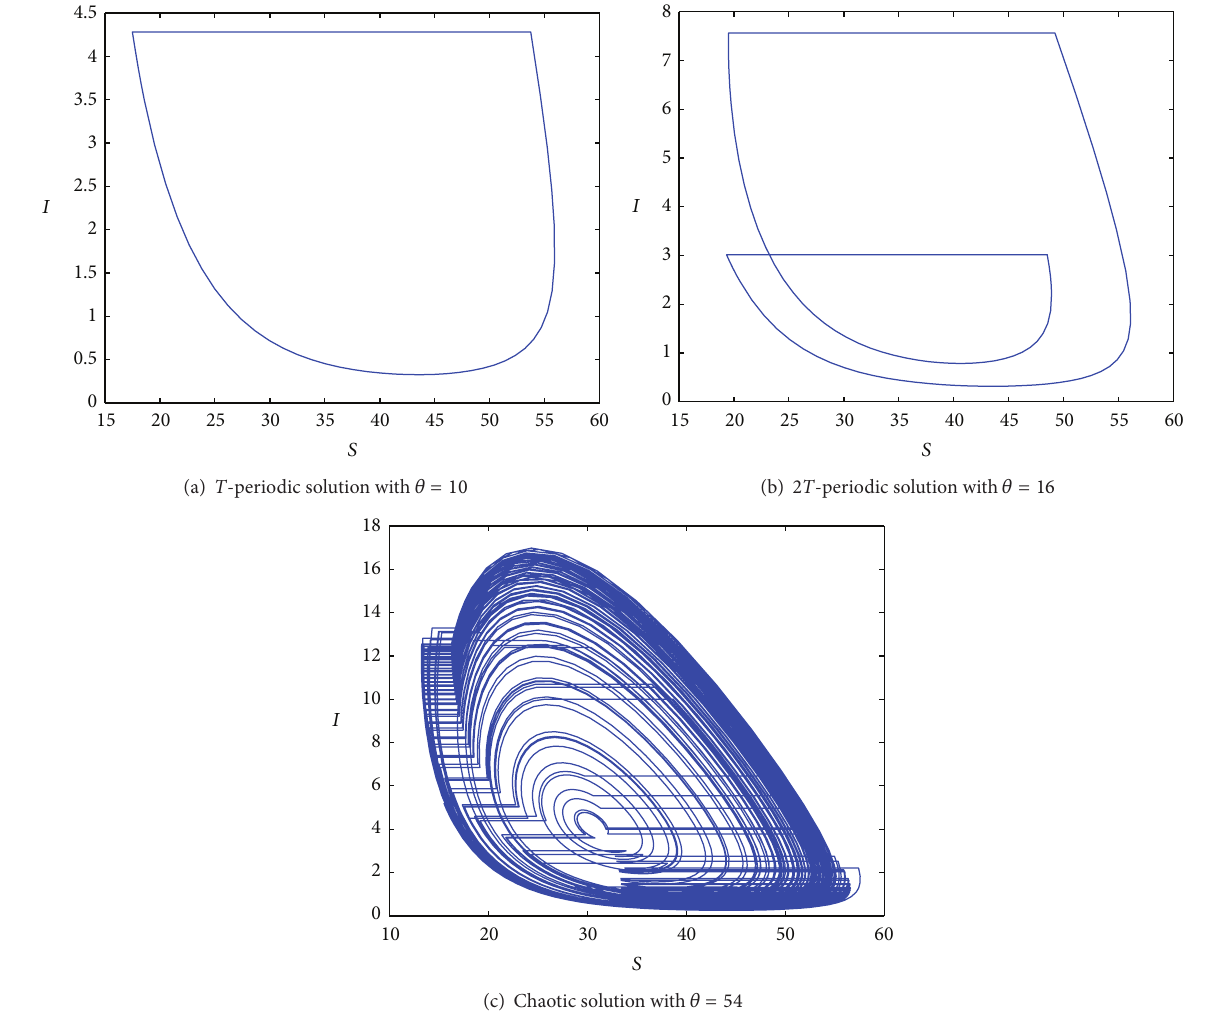
Figure 3: Phase portraits of system (8).